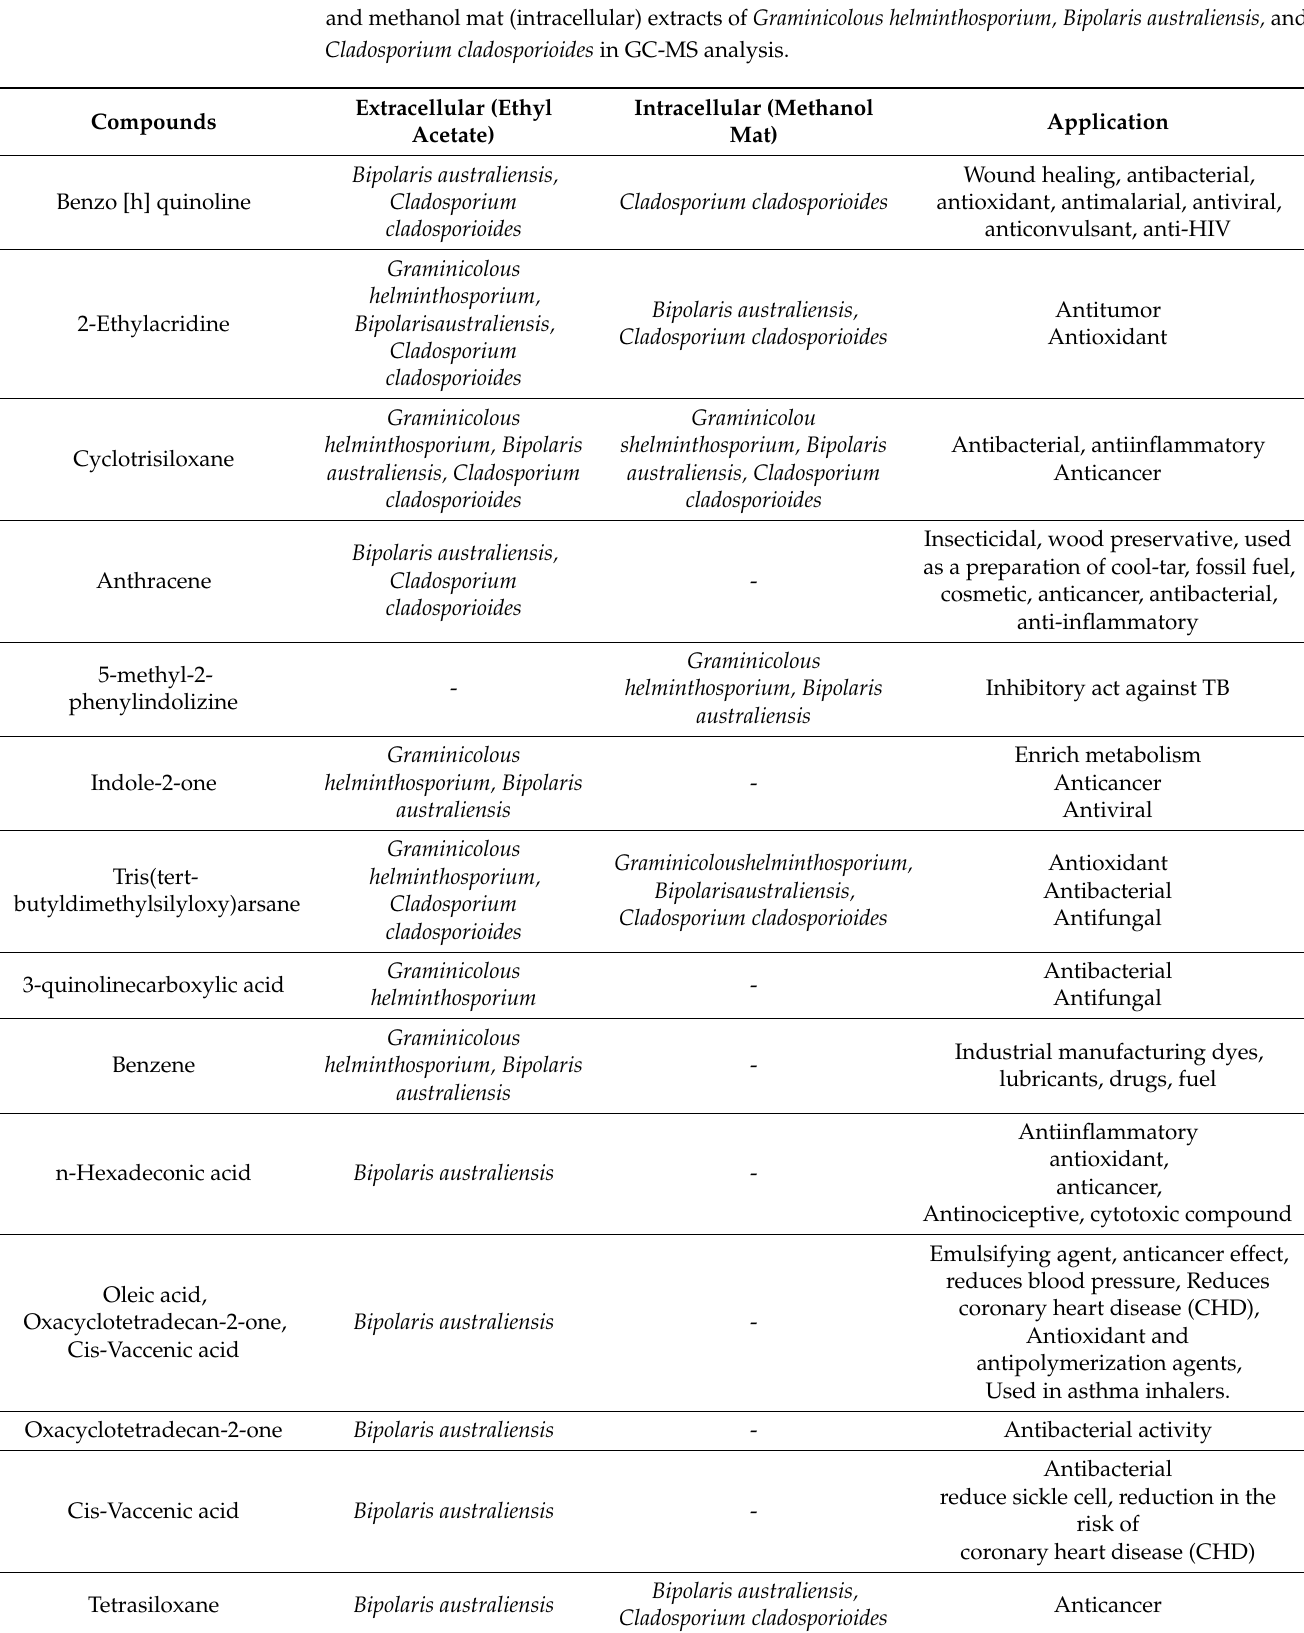
Table 2. Screening and characterization of bioactive compounds from ethyl acetate (extracellular) and methanol mat (intracellular) extracts of Graminicolous helminthosporium, Bipolaris australiensis, and Cladosporium cladosporioides in GC-MS